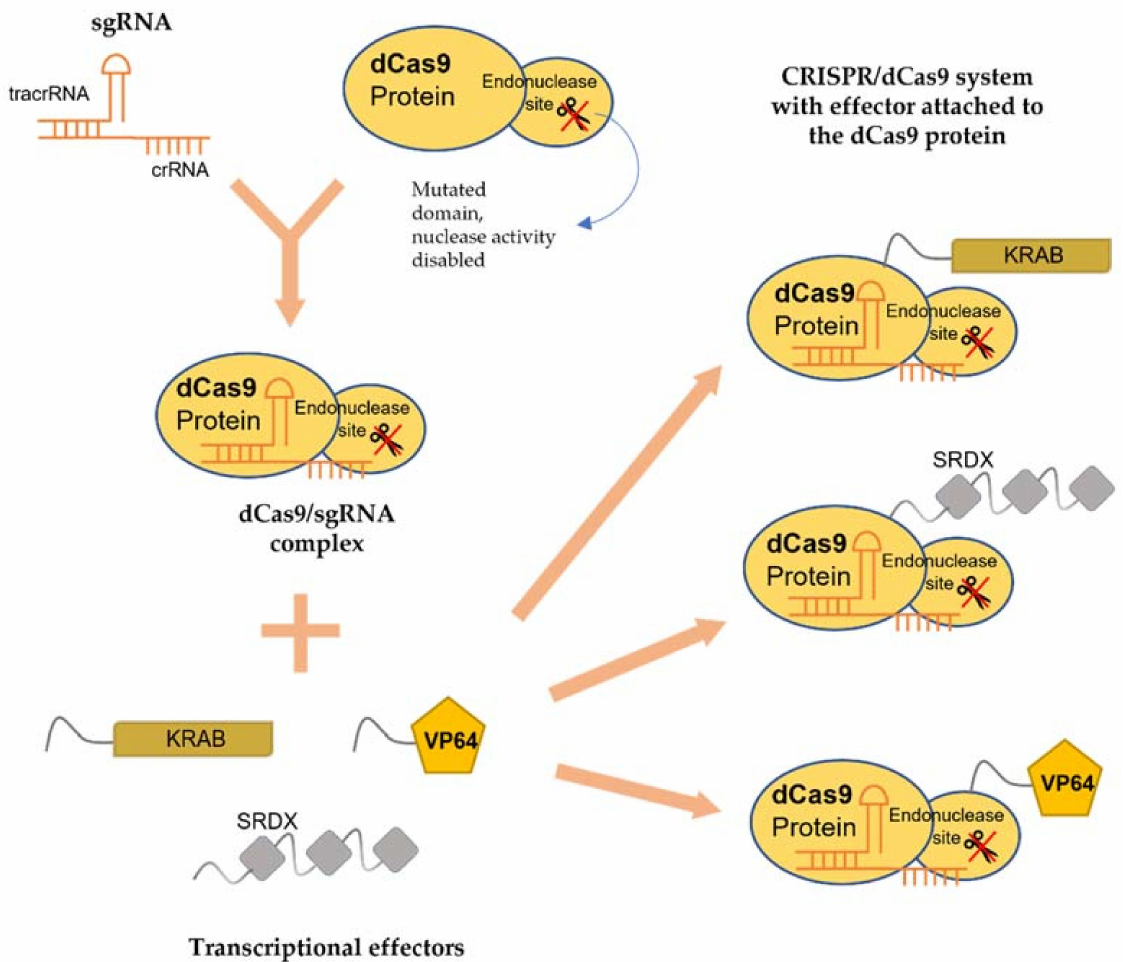
Figure 1. Schematic illustration showing sgRNA, dCas9 and transcriptional effectors. dCas9 together with sgRNA forms the dCas9/sgRNA complex for transcriptional regulator attachment. Fusion of the complex with effectors, transcription activators or repressors, are used for targeted gene